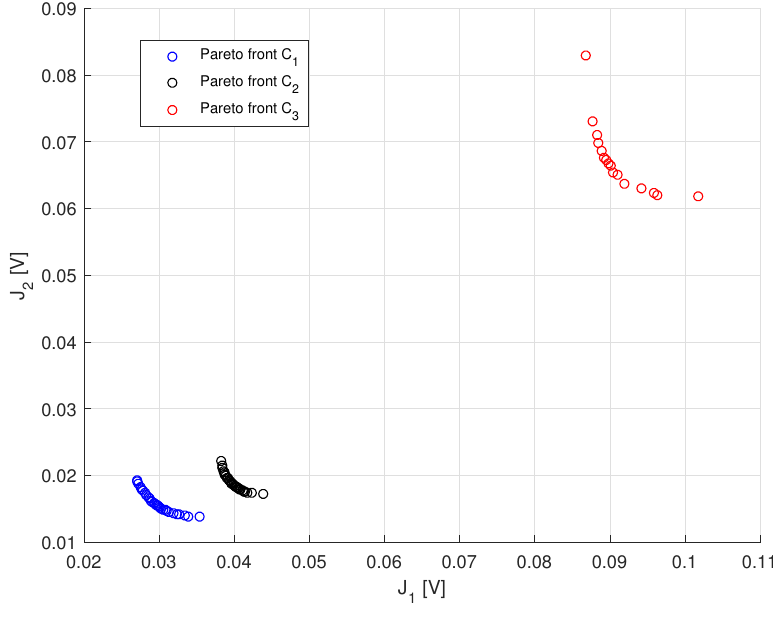
Figure 10. C 1 , C 2 and C 3 Pareto